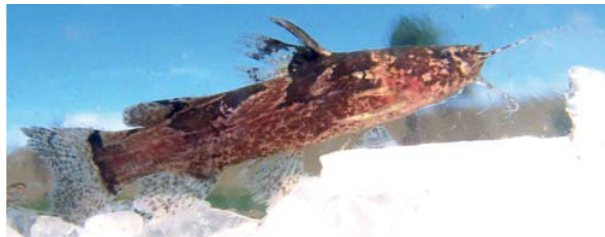
Fig. 8. Microglanis pataxo , live specimen in a field aquarium shortly after collection.